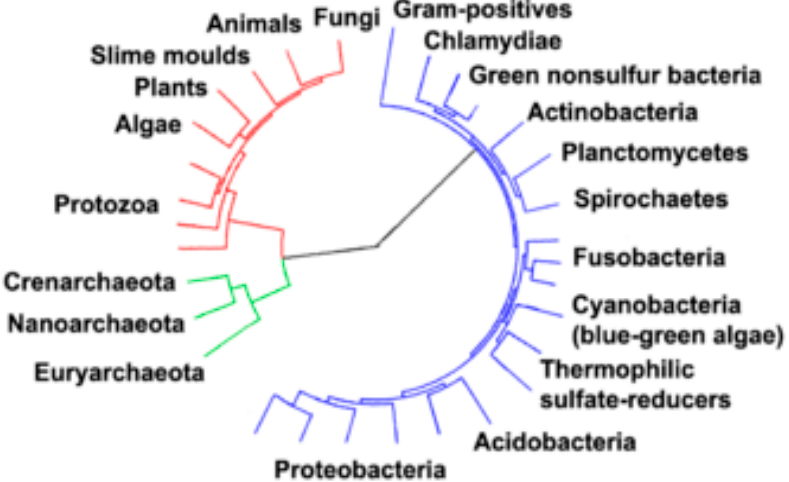
Figure 2. Phylogenetic tree showing diversity for each of the three domains of life. The bacterial domain is blue, eukaryal domain is red, while the archaeal domain is green [57] .